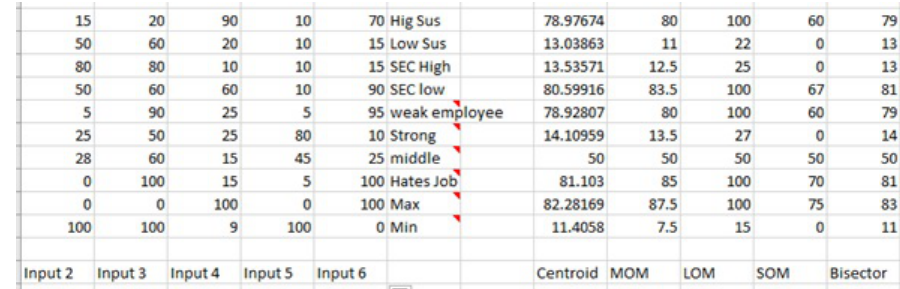
Figure 15. Defuzzification Values from an Excel